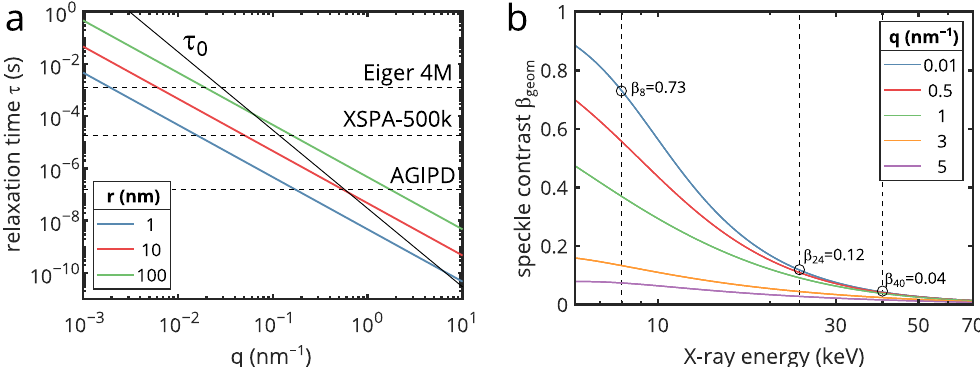
Figure 14. ( a ) q -dependence of relaxation time τ as a function of q for nanoparticles of 1 nm, 10 nm, and 100 nm radius undergoing Brownian motion in water. The solid black line marks the relaxation time τ 0 = τ ( q 0 ) at the intrinsic length scale q 0 = 2 π , the dashed line marks the repetition rate of R three detectors listed in Table 1. ( b ) Geometrical speckle contrast β geom as function of X-ray energy for some q -values. The parameters used for the calculation are: 75 µ m detector pixel size, 5 m sample-detector distance, 10 µ m beamsize, 1 mm sample thickness, and a bandwidth of a Si(111) monochromator. Contrasts are highlighted for q = 0.01 nm − 1 for 8 keV, 24 keV, and 40